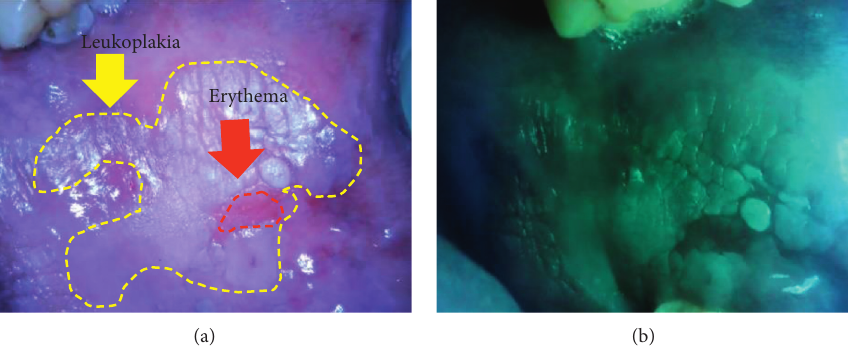
Figure 7: Images from the devices in (a) LED white light mode and (b) autofluorescent mode showing loss of fluorescence in erythema area. The image was in higher contrast, which could easily determine the outline of the